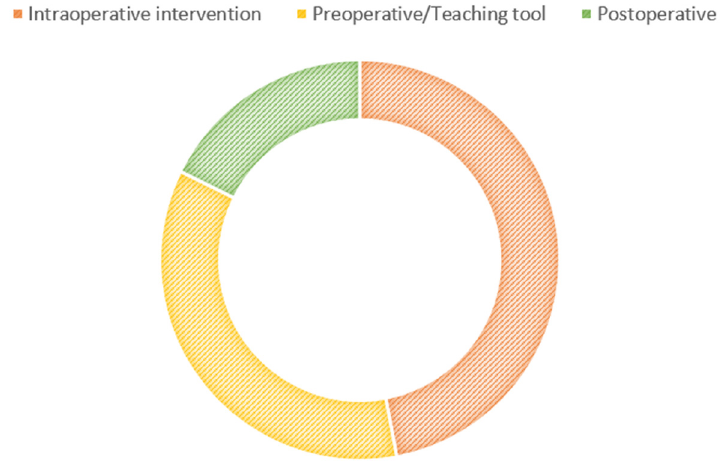
Figure 4. Use of Microsoft HoloLens.